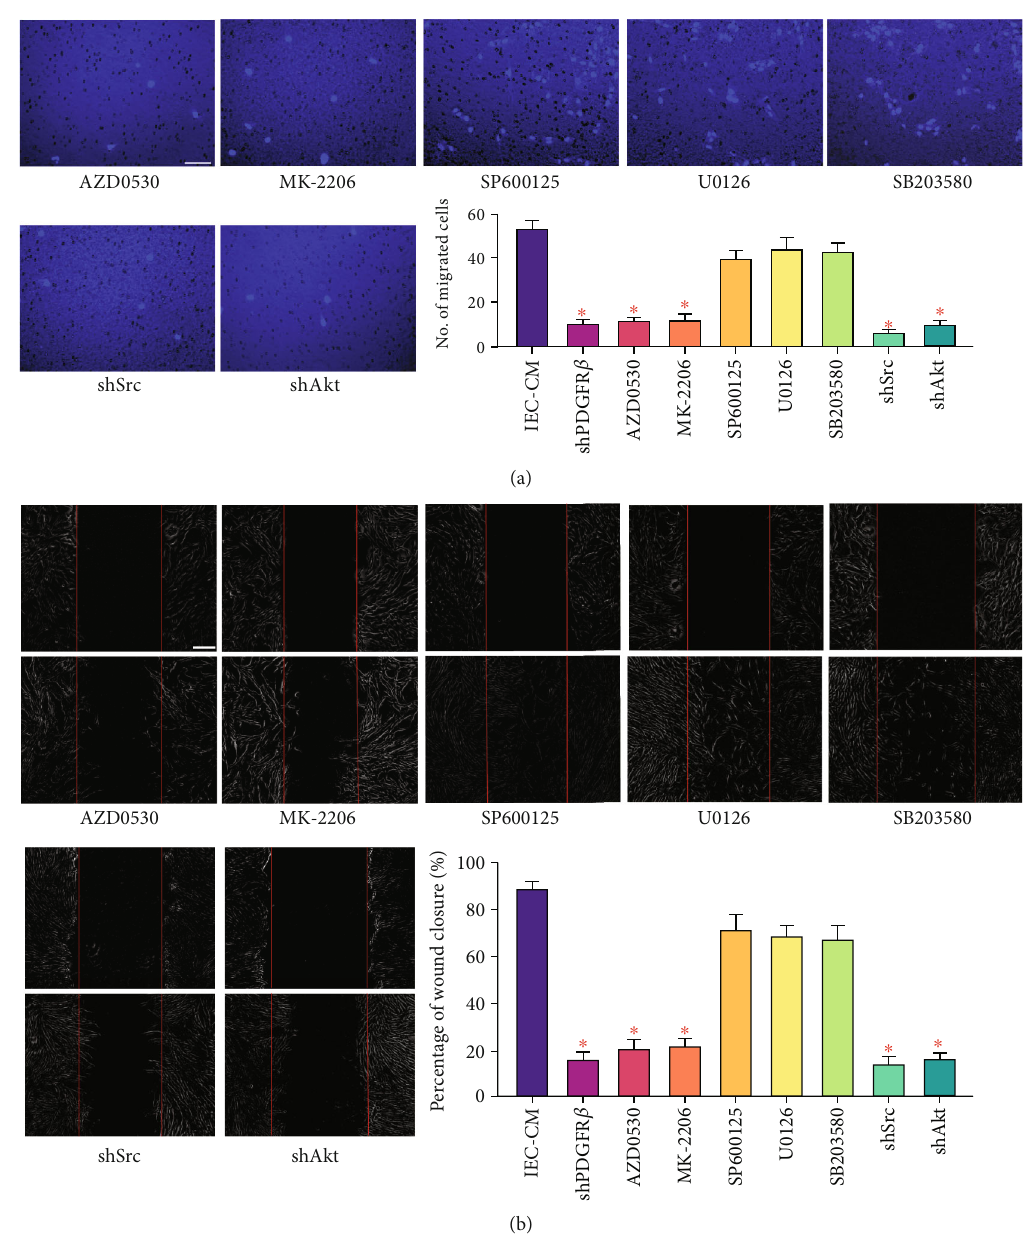
Figure 2: Src and Akt were required for ECs-induced MSCs migration in in fl ammatory microenvironment. (a) Representative images of migrated hBMSCs in Transwell culture systems. Pathway inhibitors were used for pre-treating cells migrating to IEC-CM. The quanti fi cation of migrated cells was shown as a bar graph. Data were compared with the groups of IEC-CM and shPDGFR β from Figure 1. Scale bar, 50 μ m. ∗ P < 0 : 05 . (b) Representative images of wound healing assays. The rate of scratch wound closure was shown as a bar graph. Data were compared with the groups of IEC-CM and shPDGFR β from Figure 1. Scale bar, 200 μ m. ∗ P < 0 : 05 . IEC-CM: conditioned media of endothelial cells in the context of in fl ammatory microenvironment; shPDGFR β : short hairpin RNA targeting pdgfrb ; shSrc: shRNA targeting src ; shAkt: shRNA targeting akt